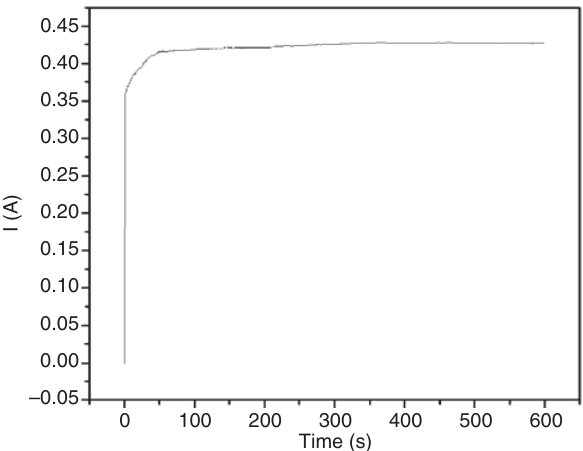
Figure 1: Current as a function of time during the synthesis process of Cu-BTC, formed from Cu and benzene-1,3,5-tricarboxylic acid